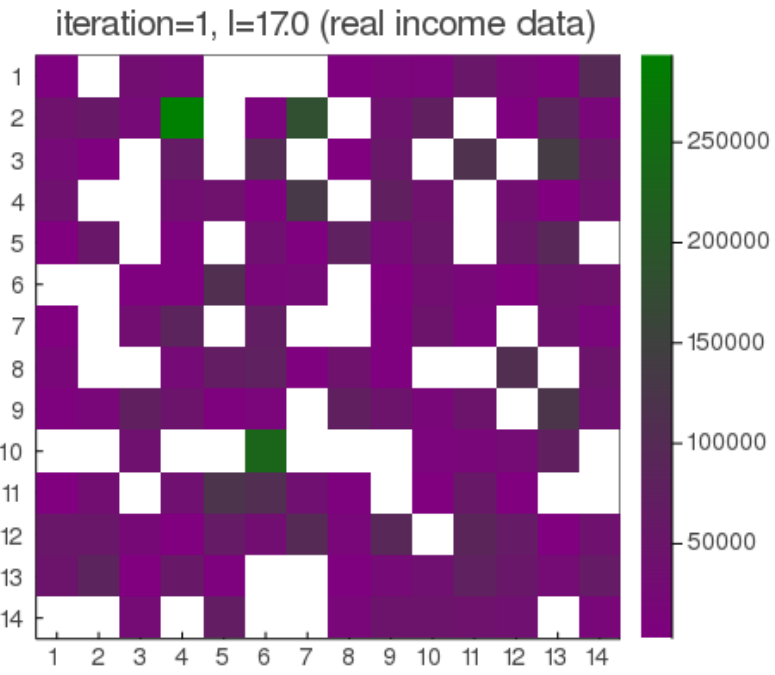
Figure 1. Homogeneity I of the income for the grid is